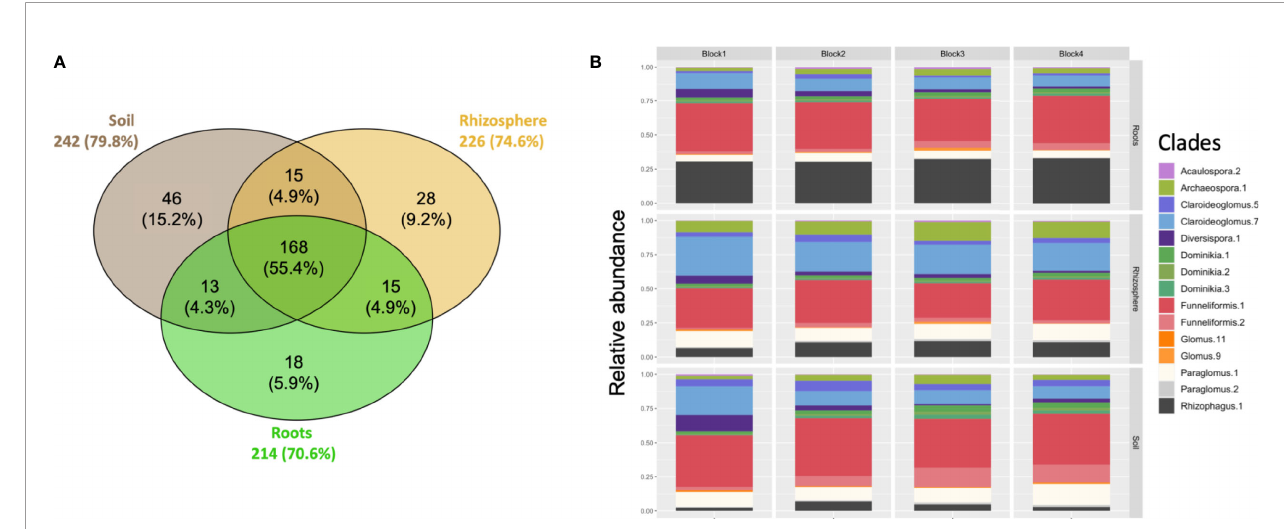
FIGURE 1 | (A) Venn diagram showing overlap of amplicon sequence variants (ASVs) between soil, rhizosphere, and root compartments. The size of the circles is proportional to the number of ASVs recorded in each compartment. Each sample was randomly subsampled to a common sequencing depth of 5000 sequences. (B) Taxonomic pro fi le of AM fungi recovered in soil, rhizosphere and root compartments for each block. The clades with a relative abundance < 1% are not